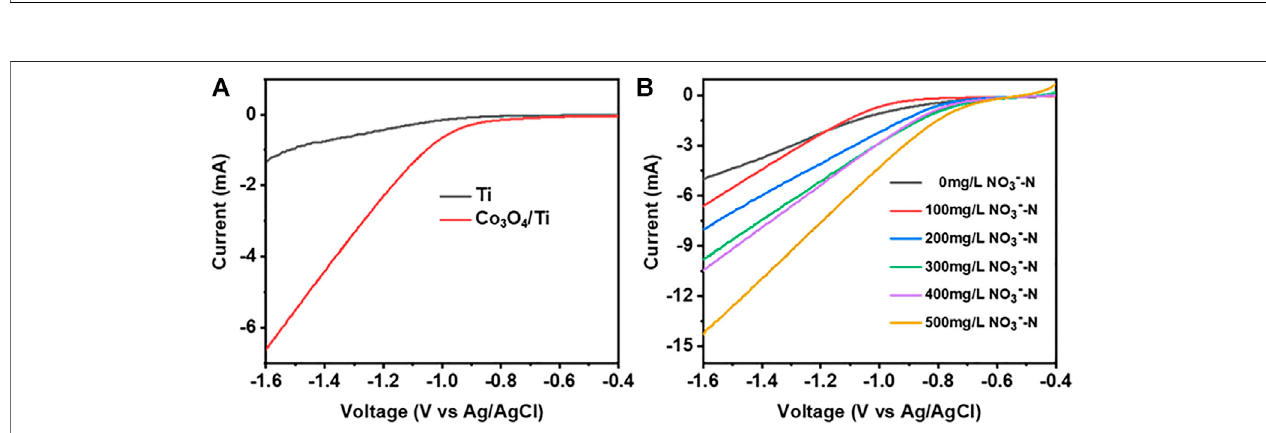
FIGURE 5 | LSV curves illustrating the NO 3 − -N removal performance of the catalysts (0.1 M Na 2 SO 4 , 10 mV/s). (A) Effects of different catalysts at constant initial NO 3 − -N concentration (100 mg/L). (B) Effects of increasing initial NO 3 − -N concentrations using the Co 3 O 4 /Ti cathode.